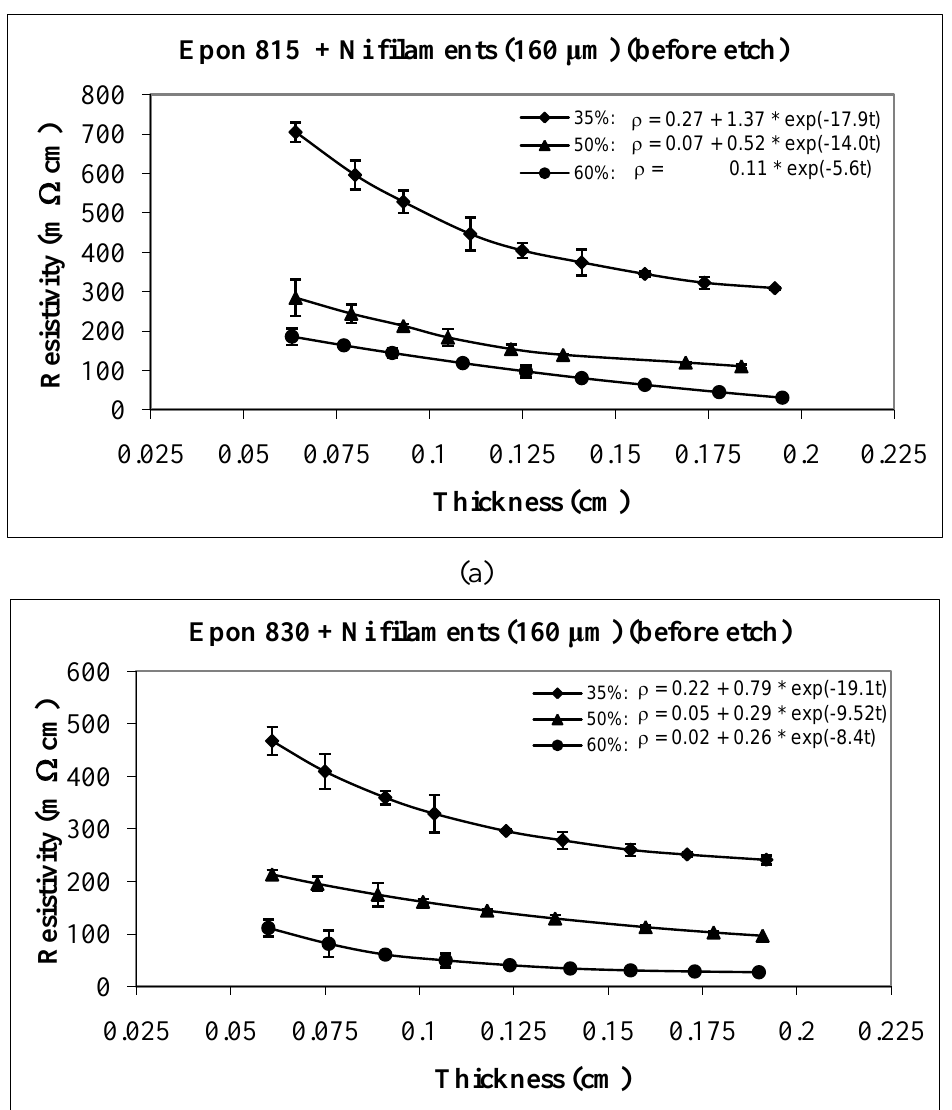
Figure 9. Thickness-dependent resistivity of Epon 815C ( a ), and 830 ( b ) films filled 35%, 50%, 60% by volume with unetched nickel filaments (160 